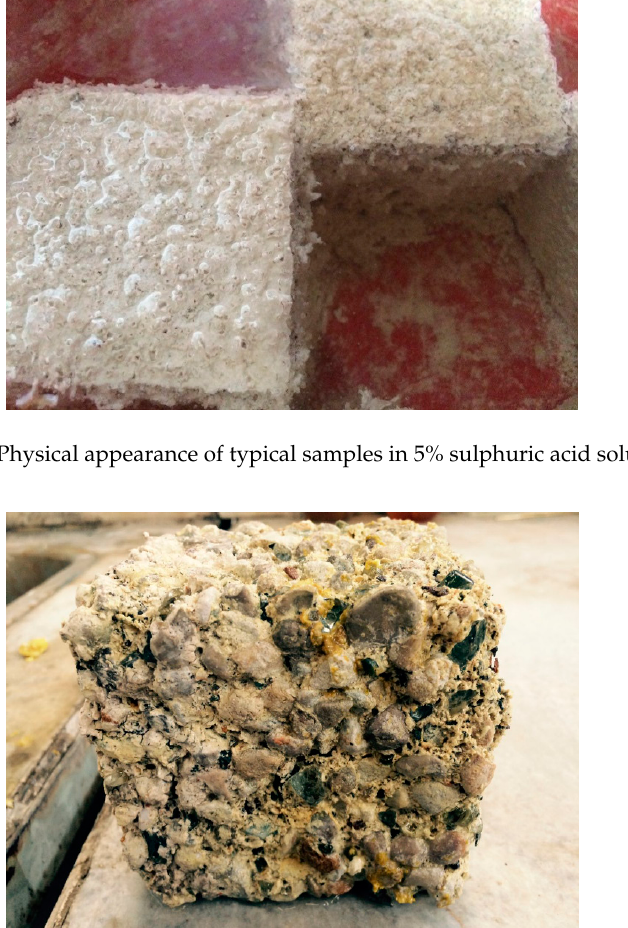
Figure 7. Physical appearance of typical samples after immersion in 5% sulphuric acid solution.